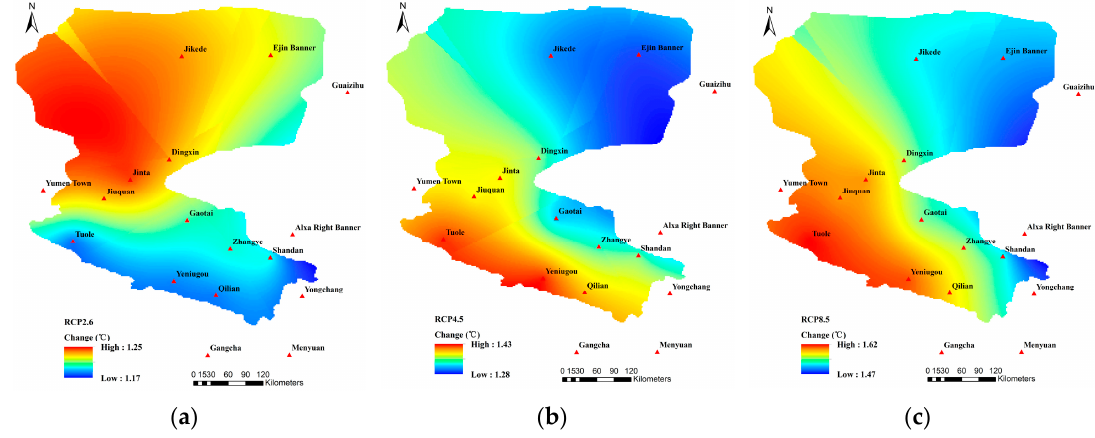
Figure 4. Spatial variation patterns of the T mean under ( a ) RCP2.6; ( b ) RCP4.5; and ( c ) RCP8.5.